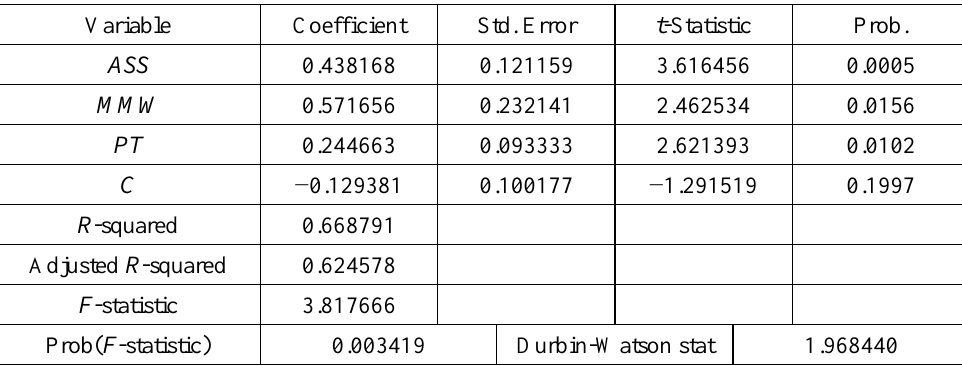
Table 6. Regression Results (authors’ computation,